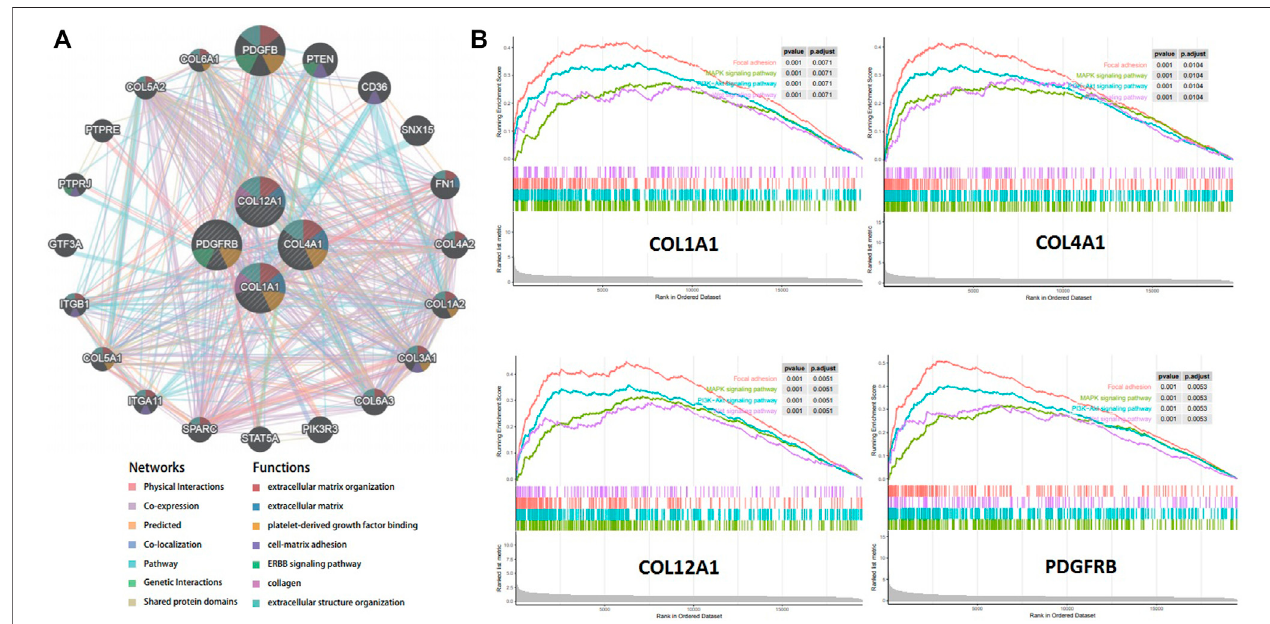
FIGURE6| FunctionPredictionforhubgenes. (A) .Protein-proteininteractionnetwork(geneMANIA)ofgastriccancerrelatedhubgenes. (B) .Genesetenrichment analysis (GSEA) of hub genes in the TCGA-STAD dataset.